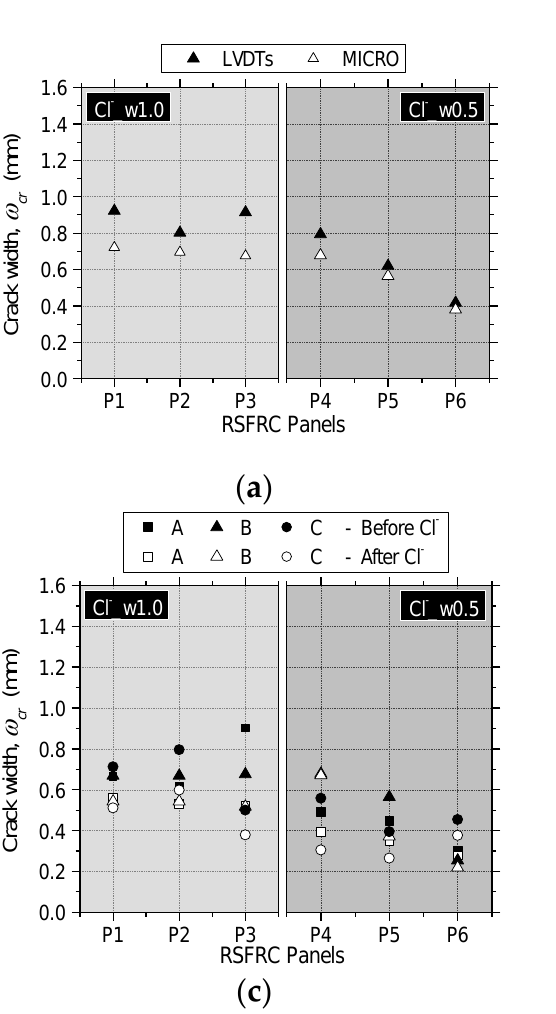
Figure 7. Crack width measurements performed with ( a ) the LVDTs and the microscope; ( b ) the microscope at each crack C1, C2, and C3 (Figure 3d); and ( c ) the microscope at each position A, B, and C (Figure 3d).